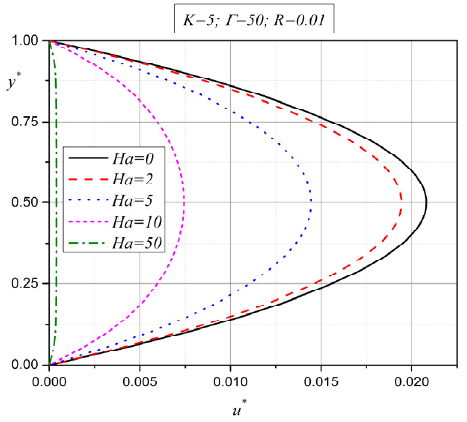
Figure 8. Influence of Hartmann number on velocity 𝑢 ∗ .